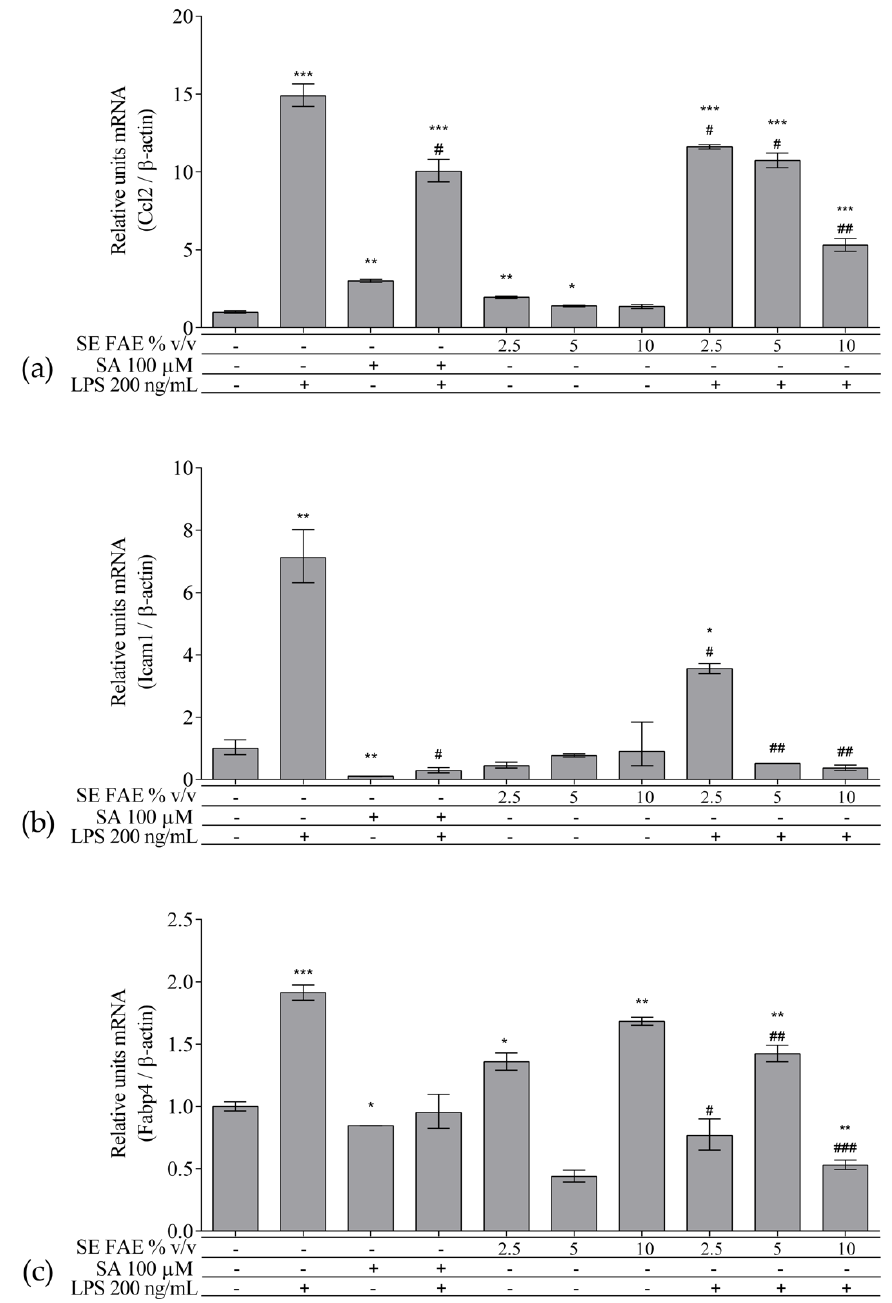
Figure 2. Changes in mRNA levels of Ccl2 ( a ), Icam1 ( b ), and Fabp4 ( c ) in J774A.1 mouse macrophages pre-treated with increasing concentrations (2.5%, 5%, 10% v / v ) of SE FAE or with SA for 24 h and subsequently stimulated or not with LPS. Results were obtained using qPCR technique. Data are presented as mean ± SEM. Legend: SE FAE– Sambucus ebulus L. fruit aqueous extract; SA–100 µ M salicylic acid; LPS–200 ng/mL lipopolysaccharides. * p < 0.05, ** p < 0.01, *** p < 0.001 vs. untreated cells; # p < 0.05, ## p < 0.01, ### p < 0.001 vs. LPS.